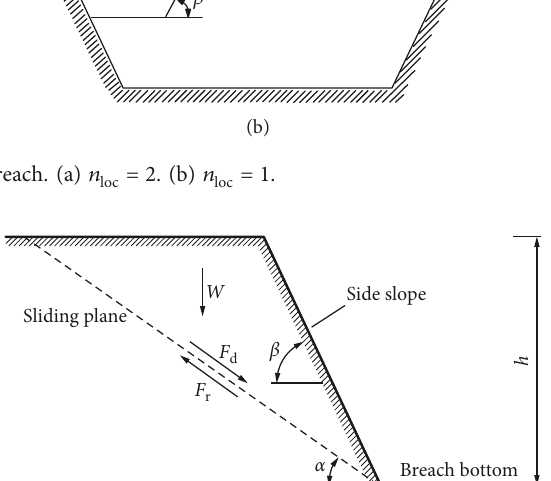
Figure 8: Analysis of side-slope